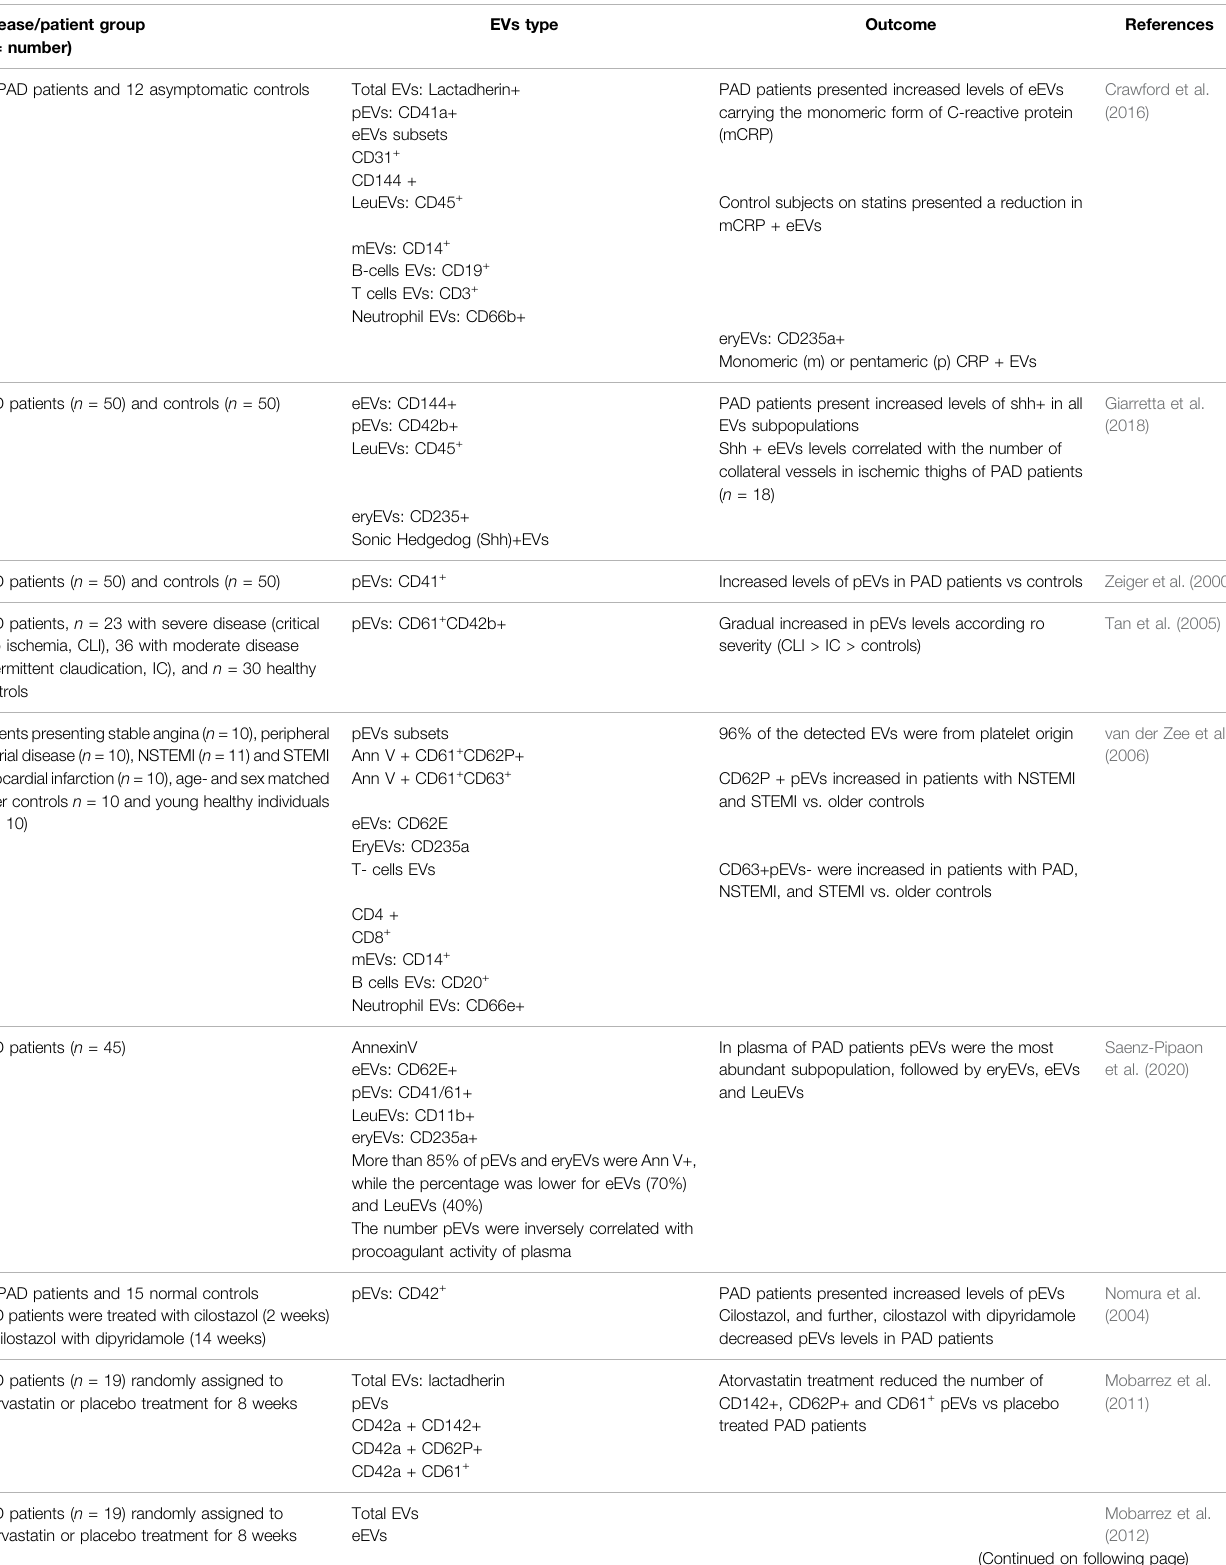
TABLE 1 | ( Continued ) Summary of studies showing a correlation between the levels of total or speci fi c cell type EVs subpopulations, measured by fl ow cytometry, in circulation (plasma) and cardiovascular